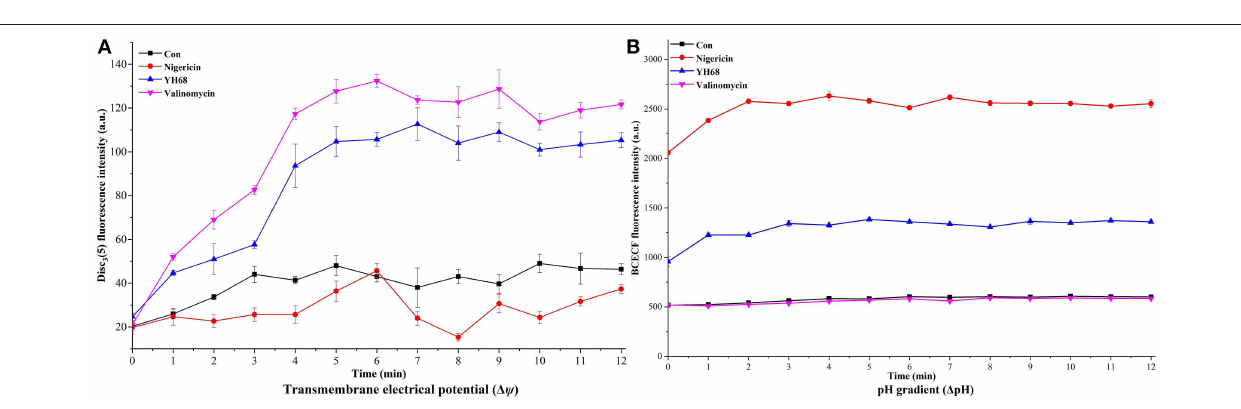
FIGURE 9 | Transmembrane electrical potential ( 1ψ ) (A) and pH gradient ( 1 pH) (B) in C. difficile ATCC